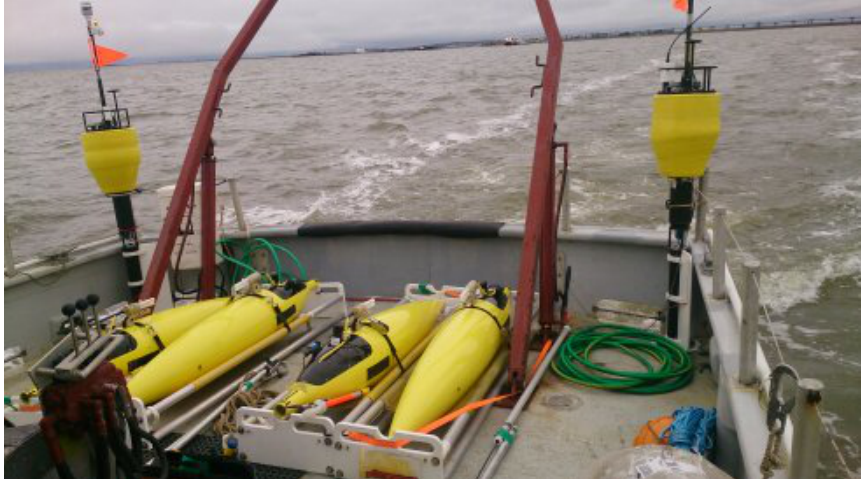
Figure 10. The University of Washington’s Applied Physics Laboratory has deployed Seagliders extensively under sea ice of the MIZ near 72 ◦ N 145 ◦ W. Image Credit: Applied Physics Laboratory, University of Washington. Reproduced with